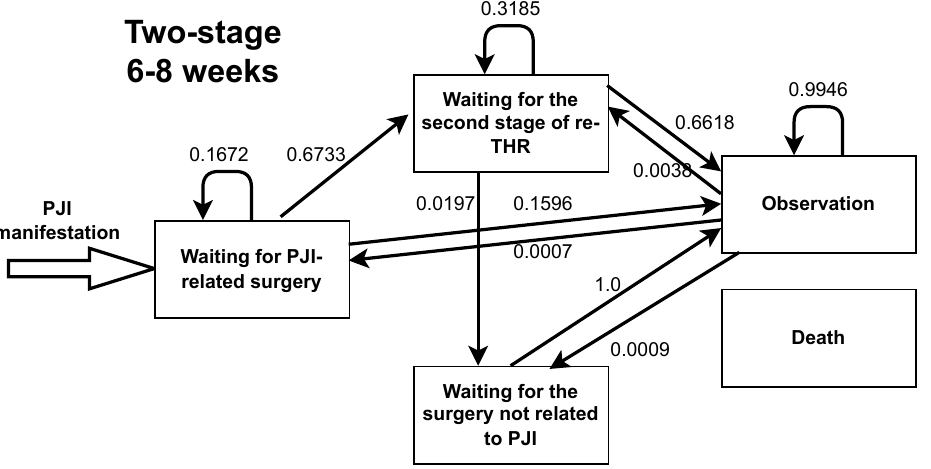
Figure A5. Markov model transition probabilities for two-stage total hip replacement with 6–8 weeks between the stages.